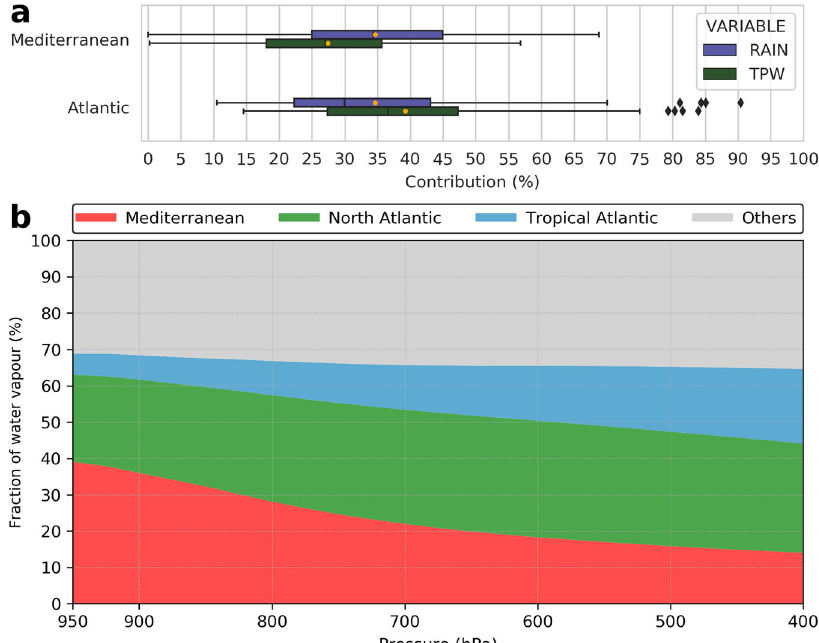
Fig. 3 Vertical distribution of the moisture from the different sources. a Comparison between the Mediterranean and Atlantic contributions to the 160 studied events in terms of rainfall (blue) and total precipitable water (TPW, green). Note that the dots in the lower right corner show the outliers of the Atlantic contributions and that the Mediterranean boxplot has no outliers. b Cumulative plot showing the vertical distribution (in pressure levels) of water vapour fractions from the different